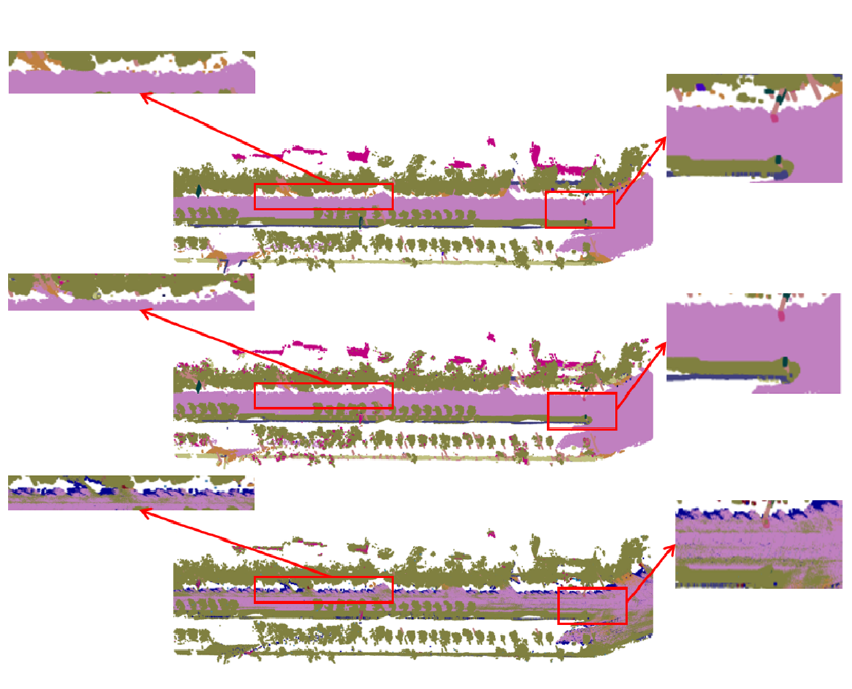
Figure 10. Visualization of Apollo dataset. From the top, ground truth, Ours, ICNET [15]. Our method is significantly better than the ICNET [15] in spatial